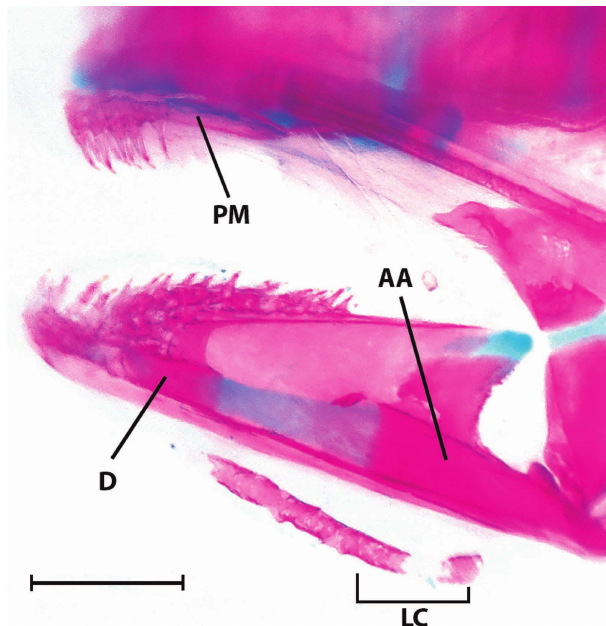
Fig. 4. Lateral view of the mandibular arch of Gelanoglanis pan , MZUSP 96032, paratype, 20.2 mm SL. AA = anguloarticular, D = dentary, PM = premaxilla, LC = subdivided autogenous laterosensory canal. Scale bar = 0.5